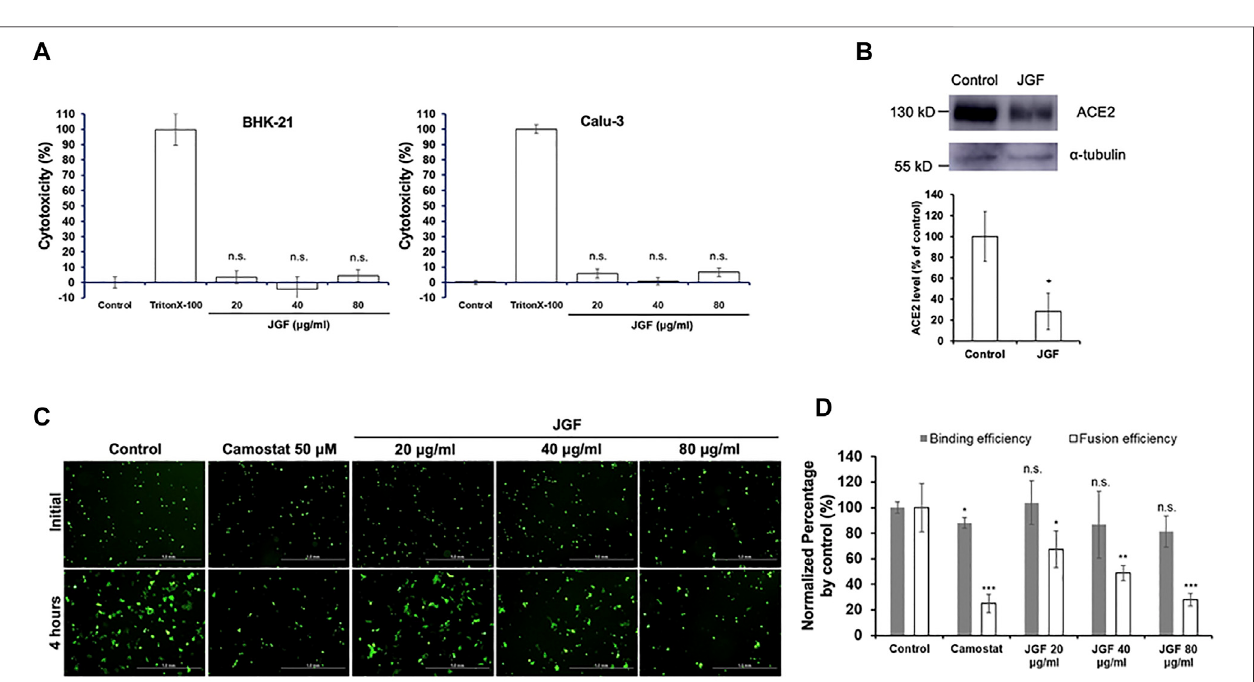
FIGURE 1 | The inhibitory activity of JGF on the interactions between SARS-CoV-2 spike (S) protein and ACE2 receptor. (A) Validation of the cytotoxicity of JGF. BHK-21 and Calu-3 cells were treated with indicated amounts of JGF and cell viability was examined by LDH assay. The control group represented the non-treatment group, serving asanegativecontrol. The treatment with Triton-100 was used asa positive control. The data were presented as the mean ±SD; error bars indicatedSD. n. s indicated non-signi fi cant, compared to the control group. (B) The expression of ACE2 in Calu-3 cells were treated with 40 μ g/ml of JGF was analyzed by Western blot assay (upper panel). The level of ACE2 expression was quanti fi ed after normalization with α -tubulin. The quanti fi cation analysis from three independent experiments was shown in bottom panel. * represents p < 0.05. (C) The cell-cell fusion of SARS-CoV-2 S protein-expressing BHK cells and ACE2-expressing Calu-3 cells was visualized in the presence of indicated amounts of JGF. (D) The formation of syncytium was quanti fi ed for various concentrations of JGF. Compared with the control, syncytium formation was signi fi cantly inhibited after 20 – 80 μ g/ml JGF treatments. * represents p < 0.05.